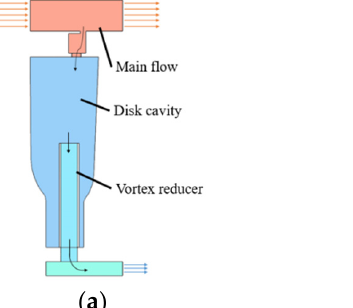
Figure 3. Flow field model of the vortex reducer in the disk cavity: ( a ) Schematic diagram of the flow field; ( b ) Computing domain division; ( c ) Grid model. field; ( b ) Computing domain division; ( c ) Grid